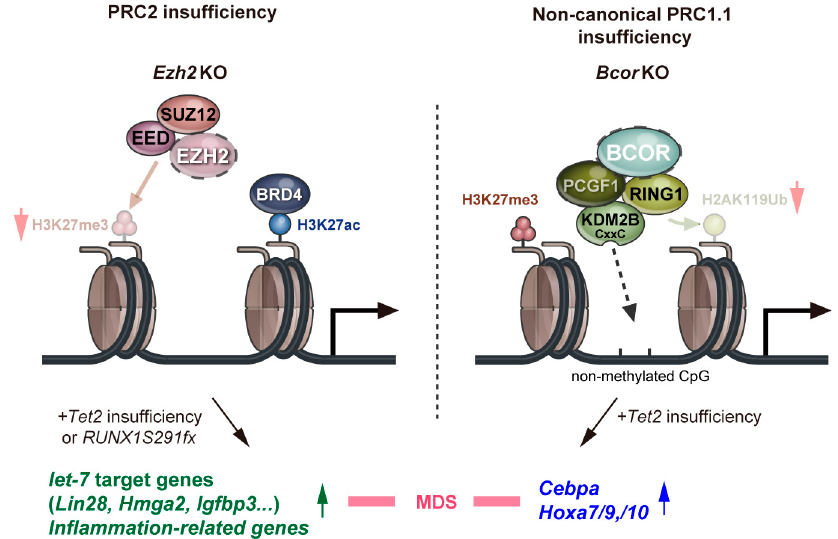
Figure 2. A model for roles of polycomb repressive complexes in the pathogenesis of MDS. Red arrows indicate a decrease in the levels of H3K27 trimethylation and H2K119 ubiquitination. Green and blue arrows indicate increased expression levels of the respective genes.